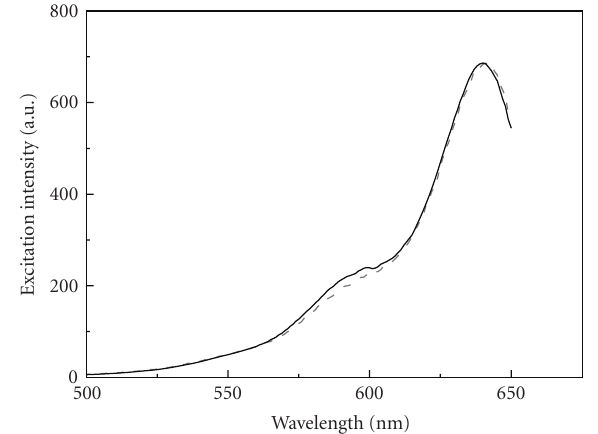
Figure 3: Excitation spectra of Cy5 (black lines) and PAH-Cy5 A (dashed grey